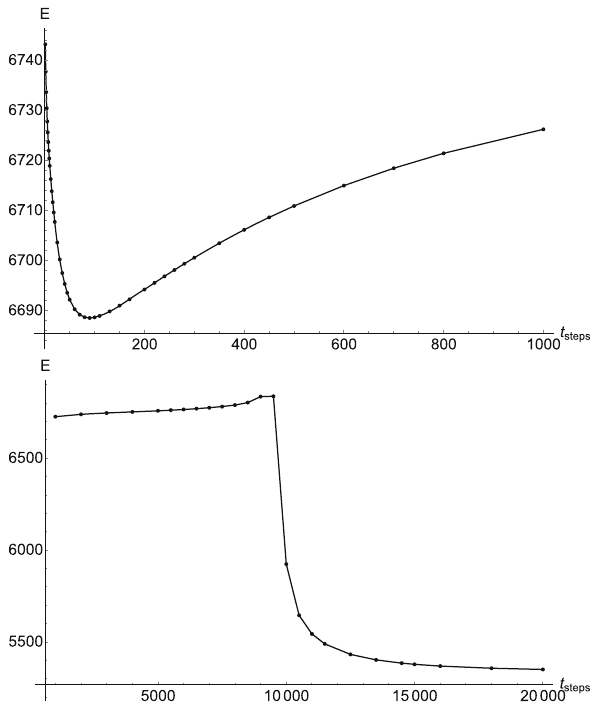
Fig. 7 We show the energy of the solutions as a function of iteration number corresponding to those shown in Fig. 6. The first graph illus- trates the rapid descent to minimum energy and gradual increase in energy. The second graph is taken over longer timescale and illustrates the metastability of the vorton just below threshold. There is a critical point at about Q ∼ 9000 where the vorton rapidly decays to the rotating Q-ball configuration